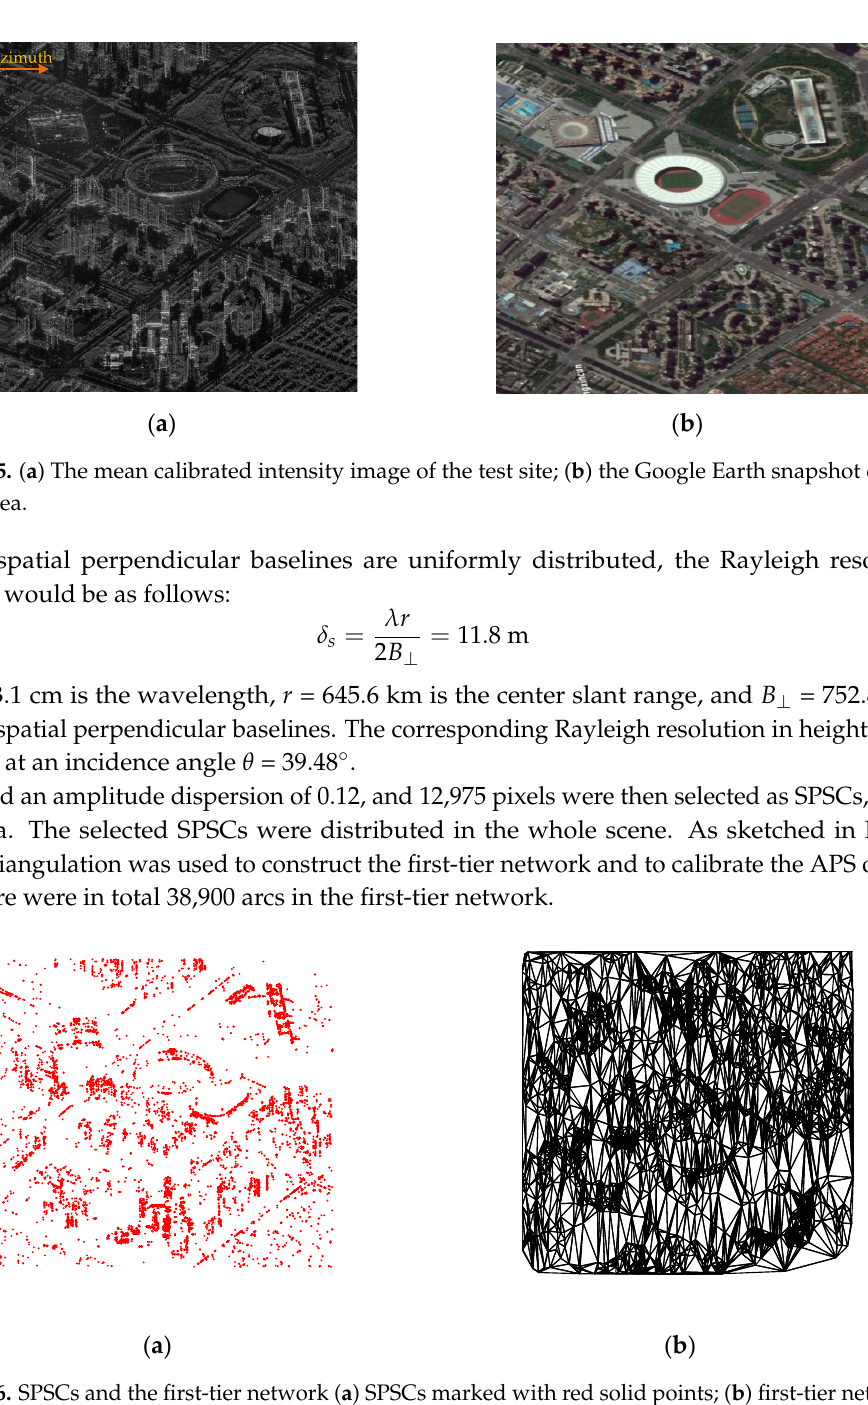
11 of 19 Figure 4. Distribution of the temporal baselines and spatial perpendicular baselines. If the spatial perpendicular baselines are uniformly distributed, the Rayleigh resolution in elevation δ s would be as follows: